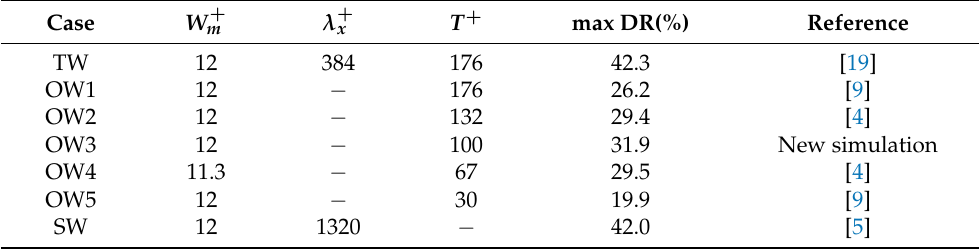
Table 1. Oscillation parameters for cases presented in Figures 1 and 2. TW—travelling wave; OW— oscillating wall (pure temporal forcing); SW—standing wave (pure spatial forcing). Reynolds number is Re θ = 505 for all